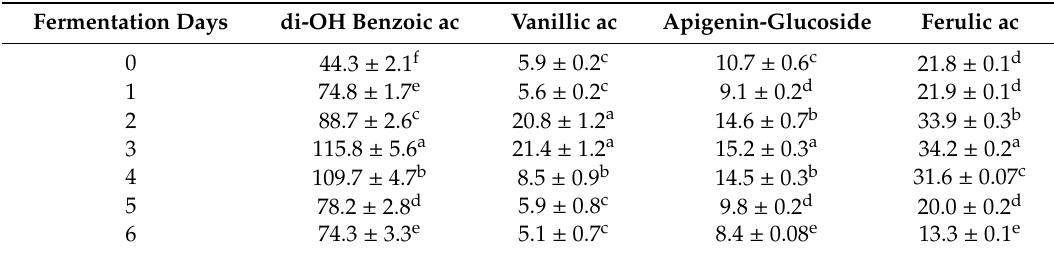
Table 2. Phenolic compounds analysis of the fermented wheat bran samples / fermentation